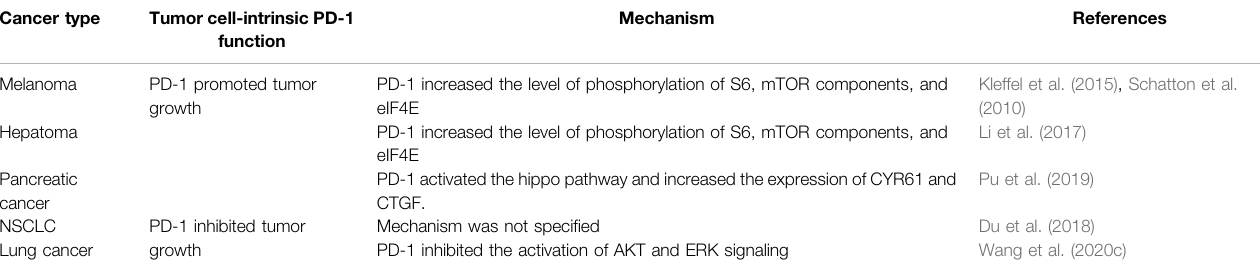
TABLE 3 | PD-1 expressed on tumor cells.